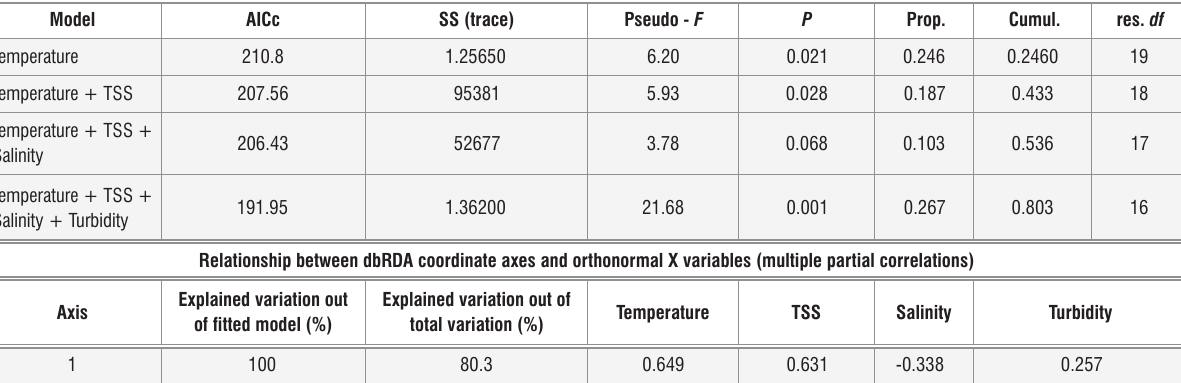
Table 2: Distance-based linear model of Meretrix morphina abundance (response) against environmental variables (predictors) measured in Lake St Lucia from 2010 to 2015. Sequential tests for stepwise model ( r 2 = 0.80), and percentage of multivariate flux variation explained by the model are presented. The most parsimonious model includes water temperature (°C), salinity, turbidity (NTU) and total suspended solids (TSS, mg/L). Model AICc SS (trace) Pseudo - F Prop. Cumul.